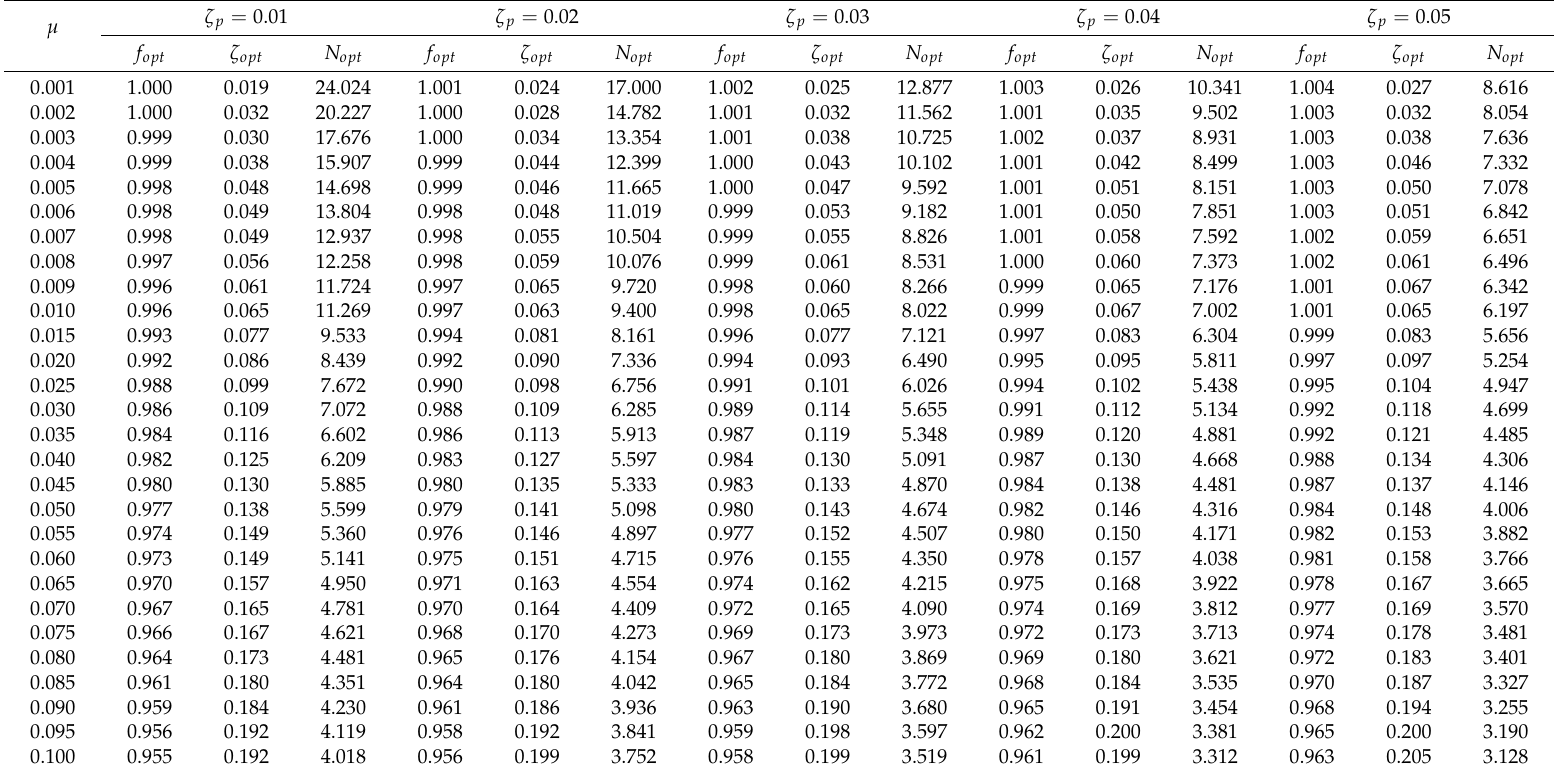
Table 1. Optimum TMD parameters for a damped primary structure under external force excitation based on AFSA for a specified mass ratio. TMD: tuned mass dampers; AFSA: artificial fish swarm